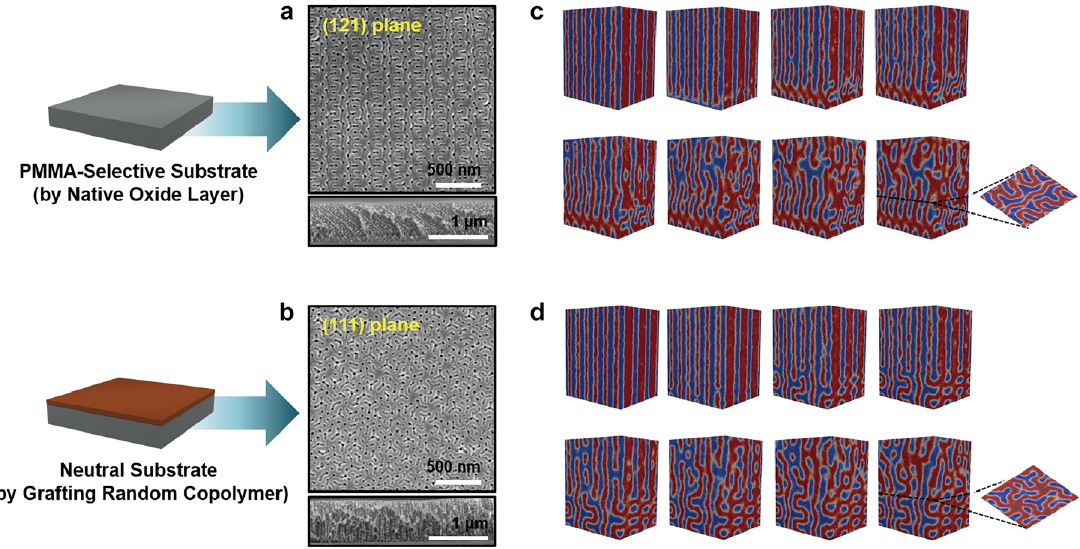
Figure 7: Controlled orientation of gyroid structures by modulating substrate interactions. (a) and (b) Top- and cross-sectional view SEM images of the PS- b -PMMA gyroid structures with (a) (121) and (b) (111) orientations. Selective and neutral interactions cause parallel and perpendicular orientations of cylinders on substrates, respectively, which consequently results in the (121) and (111) orientations of gyroid structures, respectively. (c) and (d) morphological evolution predicted in simulations of BCP fi lms developed on (c) selective and (d) neutral substrates. Reproduced with permission from ref. [53]. Copyright 2017, American Chemical Society (a) –